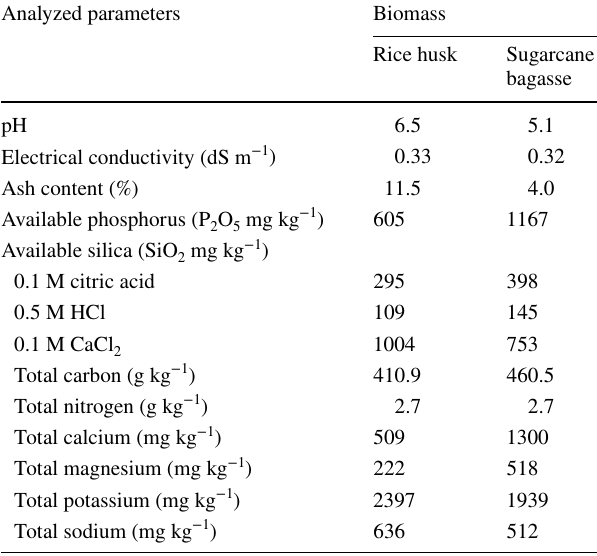
Table 1 Selected chemical properties of the original biomass prior to pyrolysis Analyzed